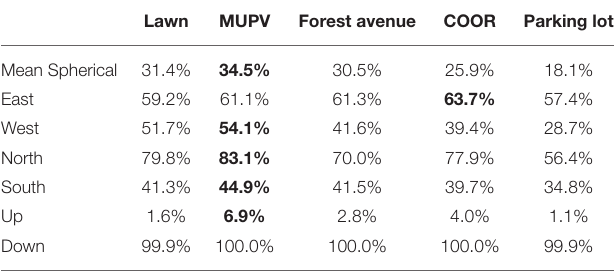
TABLE 3 | Average of reflection. Lawn MUPV Forest